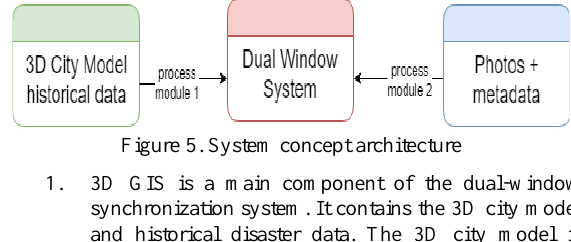
Figure 5. System concept